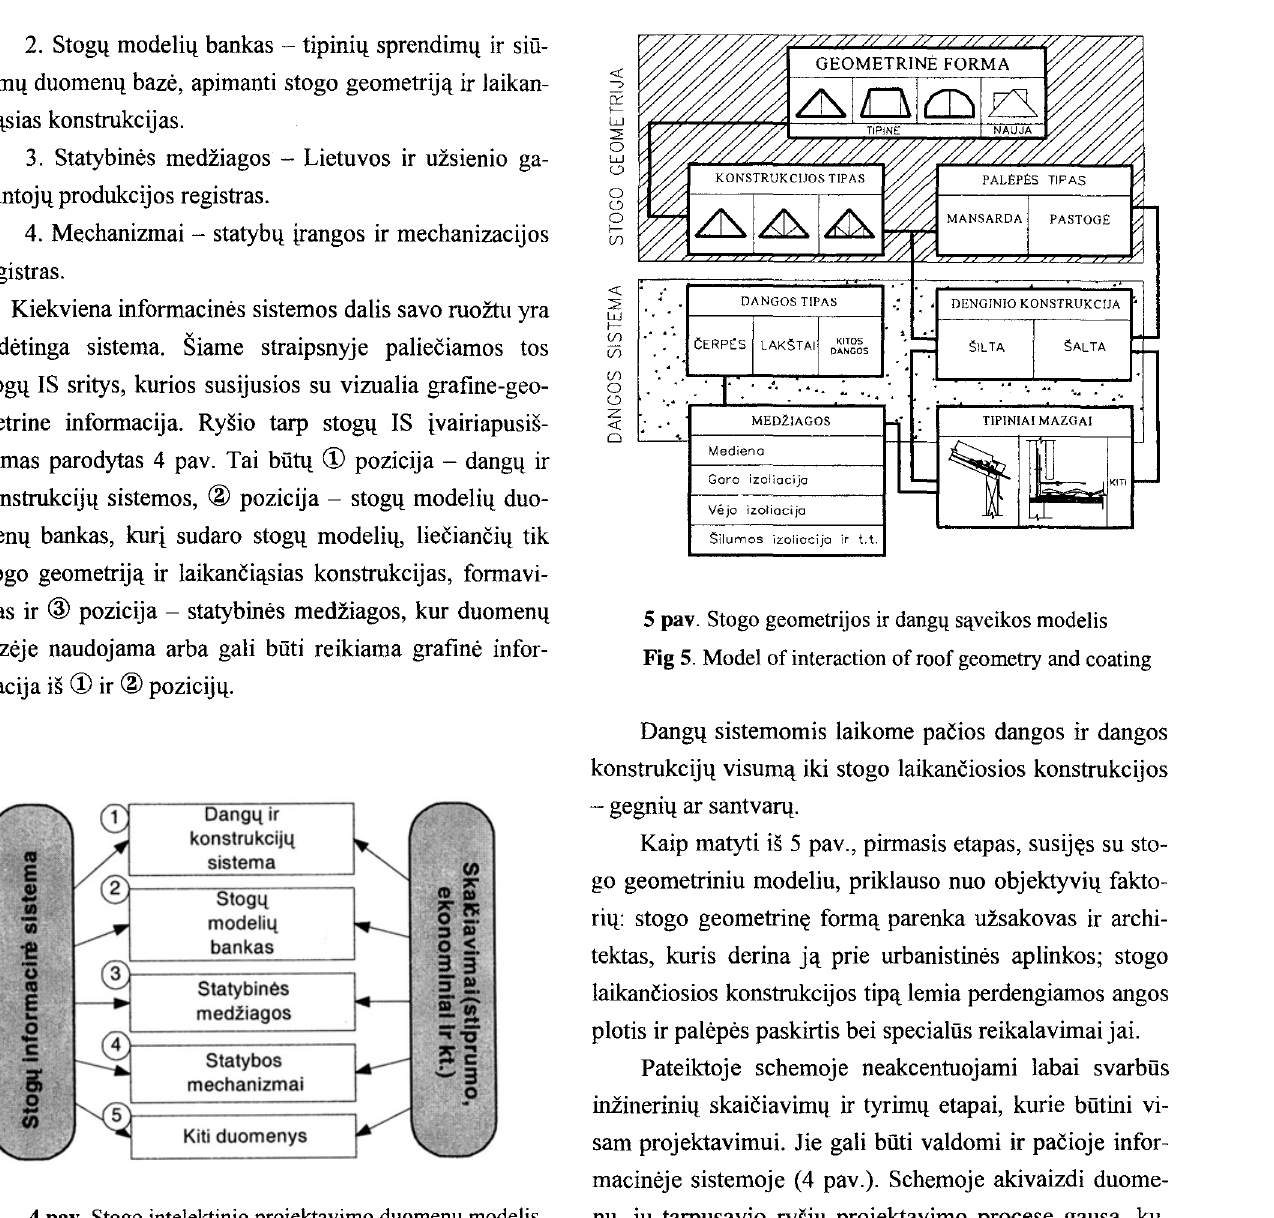
Fig 4. Model of roof intelligent design data Kadangi daugelis rekonstruotin4 gyvenamtij4 pa statl! buvo statomi pagal tipinius projektus, nam4 sien4